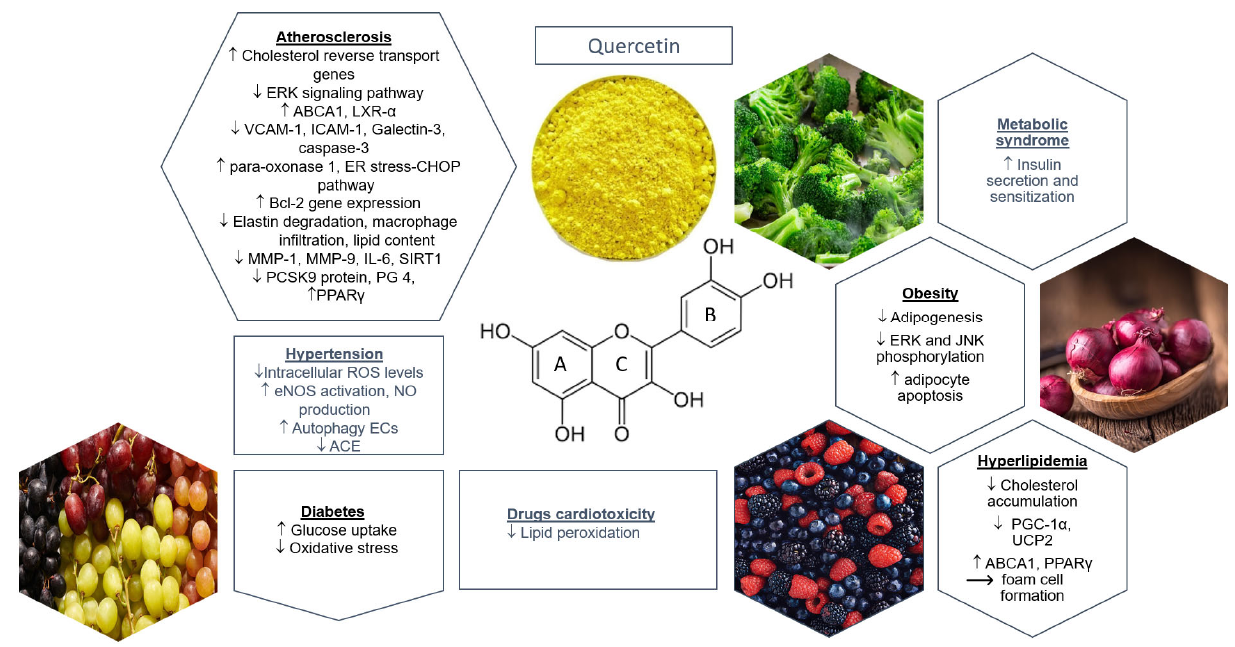
Figure 1. Schematic representation of the most important cardiovascular protective properties of quercetin and the related possible mechanism of action. Arrows indicate increase ( ↑ ) or decrease ( ↓ ) of the respective biomarker expression and the resulting formation ( → ). Key: ABCA1: ATP-binding cassette transporter A1; ACE: angiotensin-converting enzyme; Bcl-2: B cell lymphoma-2; CHOP: C/EBP homologous protein; ECs: endothelial cells; eNOS: endothelial NO synthase; ER: endoplasmic reticulum; ERK: extracellular signal-regulated kinase; ICAM-1: intercellular adhesion molecule 1; IL-6: interleukin 6; JNK: Jun N-terminal kinase; LXR- α : liver X receptor; MMP: matrix metalloproteinase; PCSK9: proprotein convertase subtilisin/kexin type 9; PG: prostaglandin; PGC-1 α : peroxisome proliferator ‐ activated receptor γ coactivator ‐ 1 α ; PPAR γ : peroxisome proliferator ‐ activated receptor γ ; ROS: reactive oxygen species; SIRT1: sirtuin 1; UCP2: uncoupling protein 2.